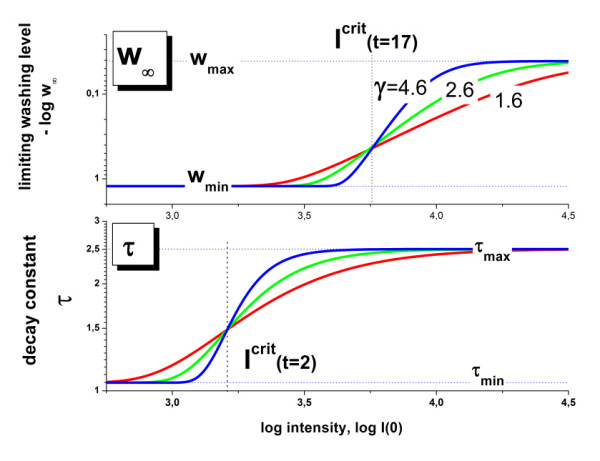
Sigmoidal "switch"-function governed by the exponential power law of the binding constant (Eq. (16)): The "switch"-functions are used to describe the intensity-dependence of the asymptotic washing level and the characteristic decay time (Eq. (18), see also Figure 5). The parameters "switch" between their minimum and maximum values at the characteristic intensity Icrit≈a'M. It depends on the number of washing cycles used for parameter estimation (see Eqs. (17) and (18)). The limiting decay times are given by τmin = 2/ln(wmin(2)) and τmax = 2/ln(wmax(2)) (see Eqs. (18) and (17)). The sharpness of the step is governed by the exponent γ (see figure).